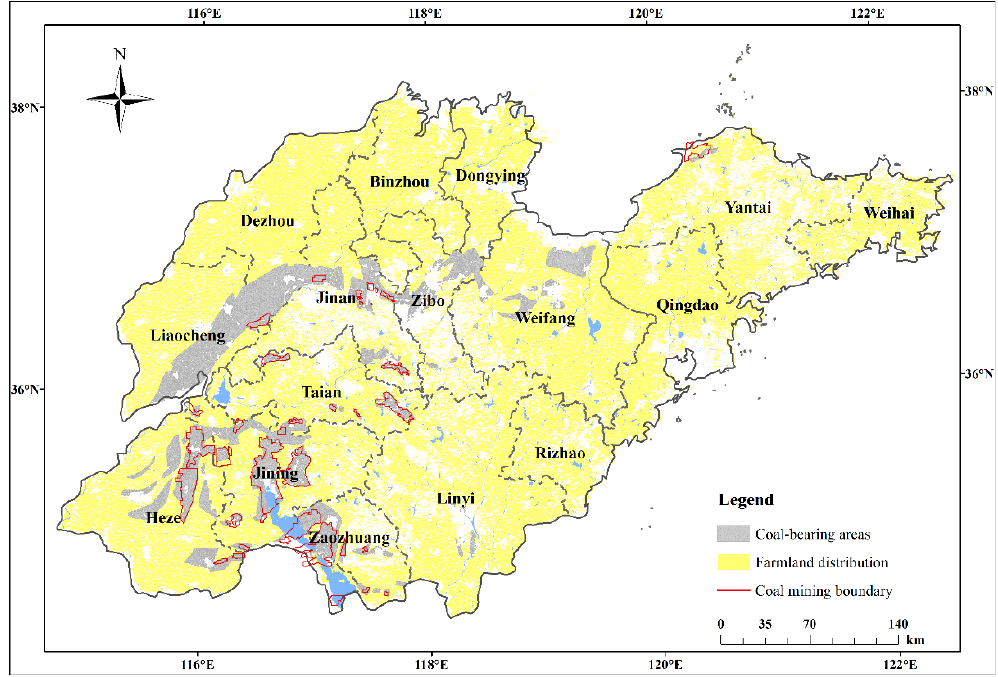
Figure 2. Spatial distribution of the coal–crop overlapped areas. (The relevant data in the figure comes from Shandong Natural Resources Bureau, Energy Bureau, and mining enterprises.).